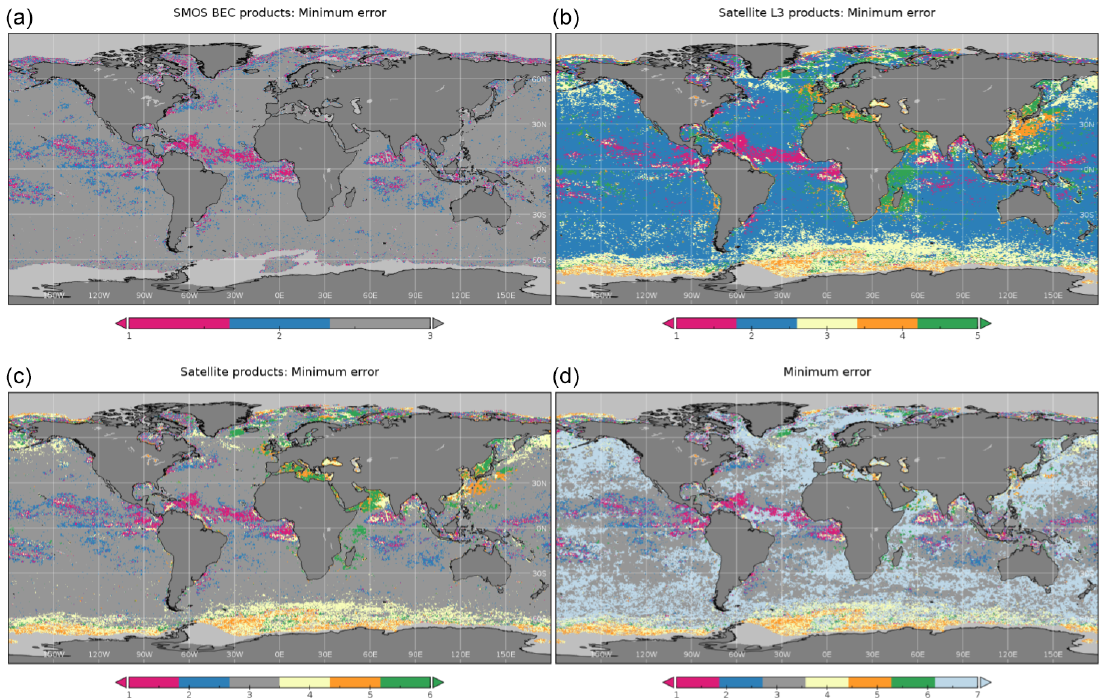
Figure 19. Spatial distribution of the products with the minimum SSS estimated error. (a) The product with the lowest error among the BEC products (1-BEC HR, 2-BEC LR, and 3-BEC L4). (b) The product with the lowest error among the L3 satellite products (1-BEC HR, 2-BEC LR, 3-CATDS, 4-JPL, and 5-REMSS). (c) The product with the lowest error among the satellite products (1-BEC HR, 2-BEC LR, 3-BEC L4, 4-CATDS, 5-JPL, and 6-REMSS). (d) The product with the lowest error among all the products analyzed in the study (including reanalysis) (1-BEC HR, 2-BEC LR, 3-BEC L4, 4-CATDS, 5-JPL, and 6-REMSS;